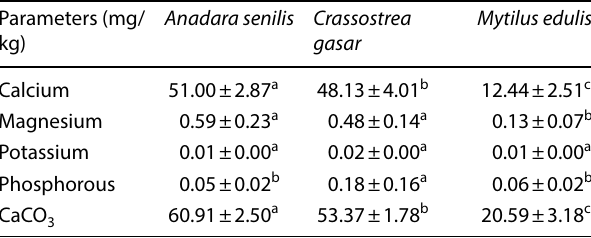
Table 2 Mean concentration of mineral contents and phytochemi- cal constituents of the bivalve shell samples